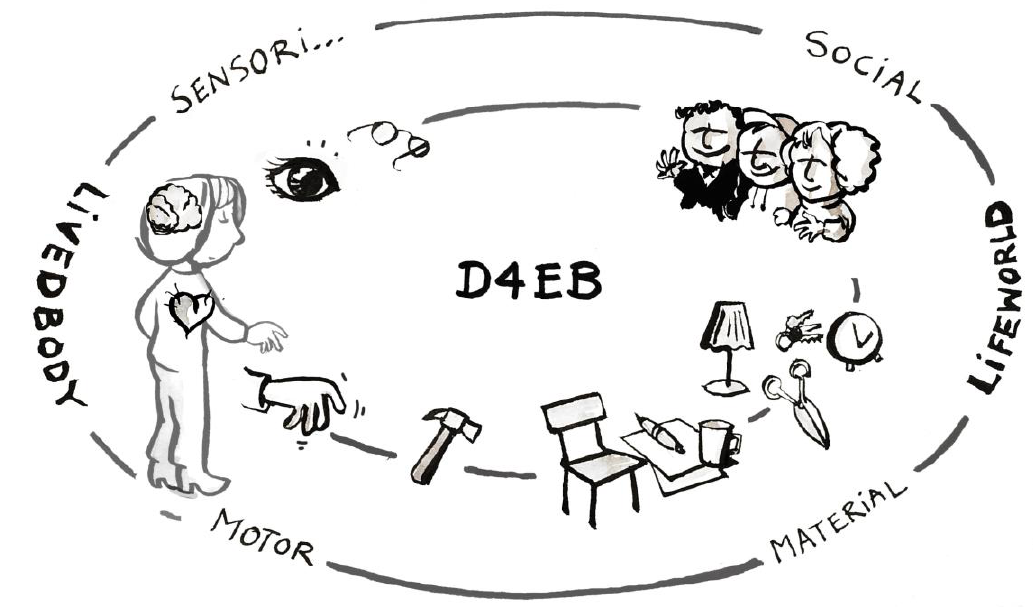
Figure 8. The D4EB theoretical framework, offering a design space for hybrids as scaffolding the formation of socio-sensorimotor couplings that characterize the way the lived body operates in the social and material lifeworld. © Jelle van Dijk.